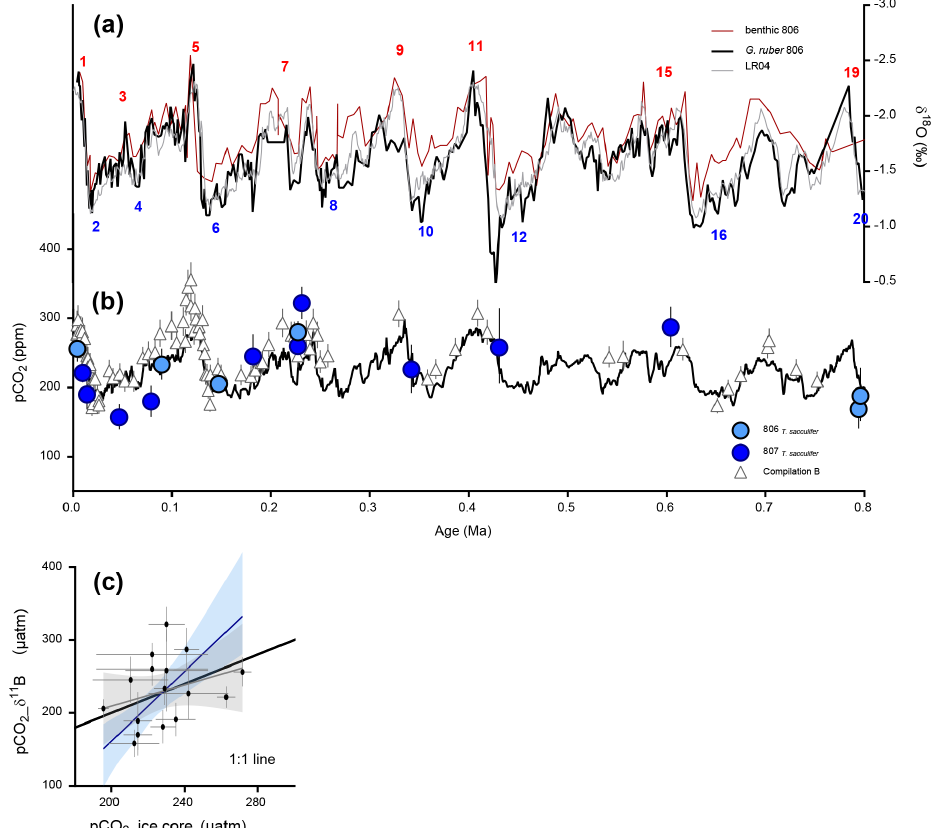
Figure 3. (a) Reconstruction of surface p CO 2 (ppm) for the past 0.8Myr from T. sacculifer at ODP Sites 806 and 807 (blue symbols) using boron-based pH calculated from δ 11 B seawater (Greenop et al., 2017) and alkalinity from Caves et al. (2016). Planktonic foraminiferal δ 18 O at site 806 with isotope stages labeled (black line – Medina-Elizalde and Lea, 2005) and benthic foraminiferal δ 18 O stack (grey line – Lisiecki and Raymo, 2005), benthic δ 18 O at Site 806 (dark red line) from Lear et al. (2003, 2015). (b) p CO 2 values calculated from boron isotopes (colored symbols – this study) with data from the literature (open gray triangles – compilation B are data recalculated in Rae et al., 2021) and ice core p CO 2 (black line – Petit et al., 1999; Lüthi et al., 2008; Bereiter et al., 2015). (c) Cross plot for the last 0.8Myr of p CO from this study and p CO 2 ice core (from ice core compilation, Bereiter et al., 2015), grey line is a simple linear regression 2 δ 11 B ( p = 0 . 25, R 2 = 0 . 09), blue line is a Deming regression taking both x and y uncertainties into account ( p = 0 . 25). Details of the regression parameters are in Table S6. Ice core CO 2 error was calculated based on 2SD of reported values, and ± 1kyr for the age of sediment samples. Boron-based p CO 2 error is calculated based on error propagation described by Eq. (S17). Data compiled are from Foster (2008); Hönisch and Hemming (2009); Seki et al. (2010); Foster et al. (2012); Badger et al. (2013); Greenop et al. (2014); Martínez-Botí et al. (2015a);